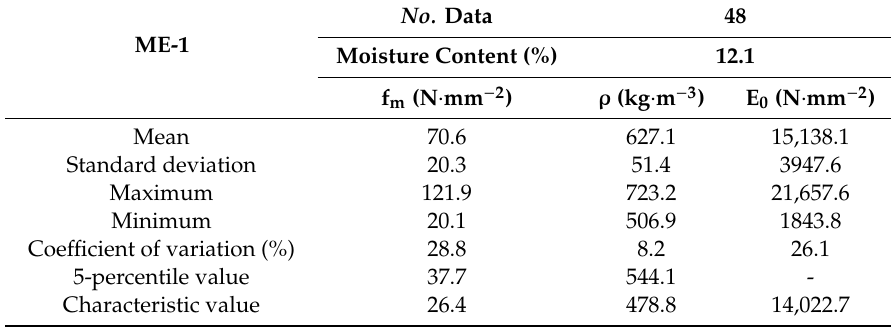
Table 3. Results of properties corresponding to grade ME-1. f m : bending strength; ρ : density; E 0 : modulus of elasticity in the bending parallel to